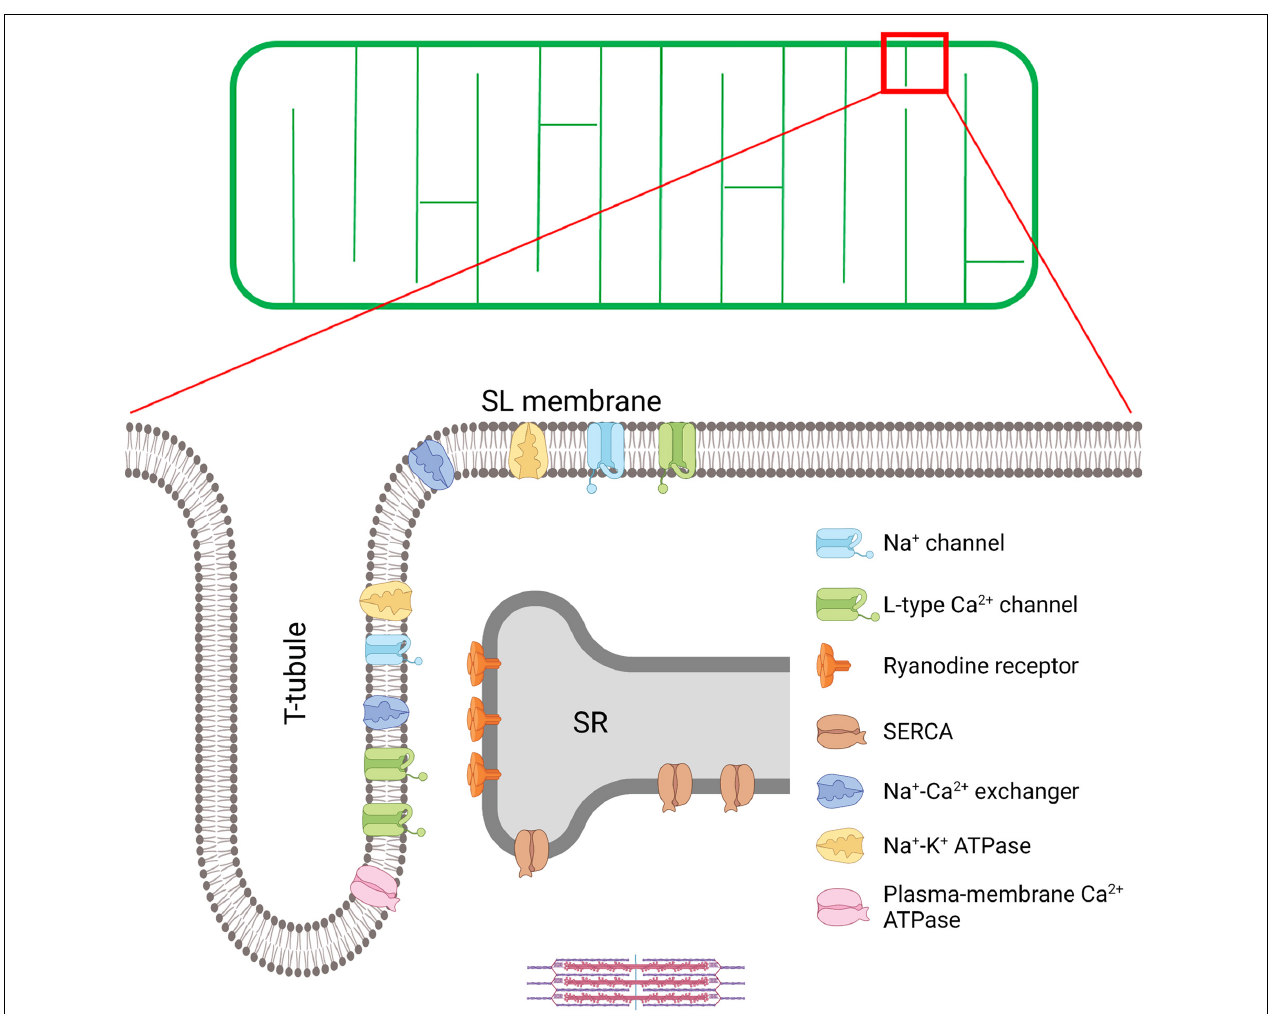
FIGURE 1 | T-tubule structure and key proteins involved in excitation-contraction (EC) coupling in the cardiomyocyte. A schematic overview of the t-tubule network is provided in the upper panel, while an enlargement of the indicated region is provided below to illustrate positioning of EC coupling proteins. EC coupling is initiated as Na + channels are opened, and the cell membrane depolarizes during the action potential. This depolarization triggers the opening of voltage-gated L-type Ca 2 + -channels (LTCCs) in the t-tubules, and subsequent Ca 2 + -induced Ca 2 + release from the SR through the opening of Ryanodine Receptors (RyRs). This process occurs at specialized junctions called dyads, where LTCCs and RyRs are in close proximity. After released Ca 2 + binds to the myofilaments to trigger contraction, Ca 2 + is recycled into the SR by the sarco-endoplasmic reticulum ATPase (SERCA), and removed from the cell by the Na + -Ca 2 + exchanger (NCX) and the plasma-membrane Ca 2 + ATPase. NCX activity is critically regulated by Na + levels, set by the Na + channel and the Na + -K + ATPase within t-tubules. Created with